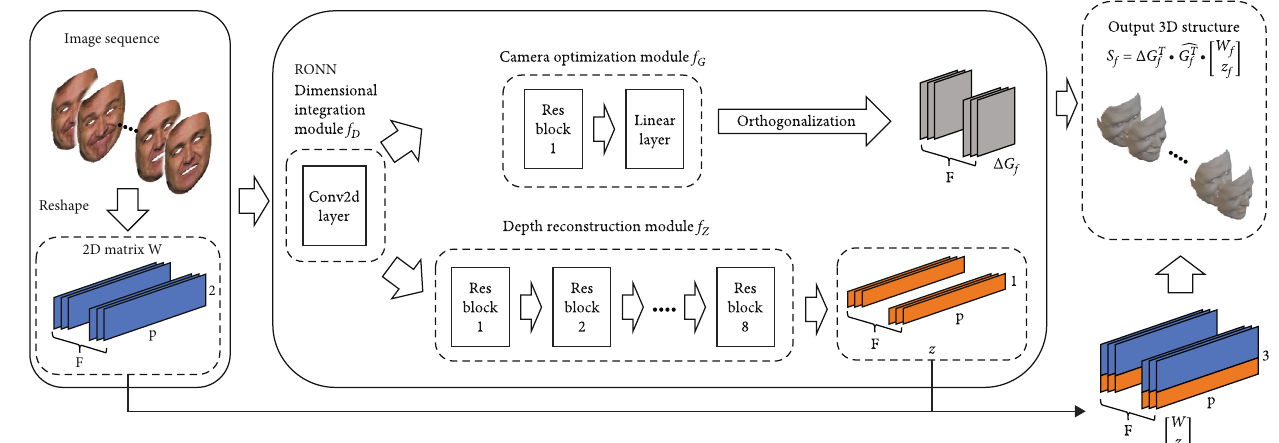
Figure 1: Overview of the proposed